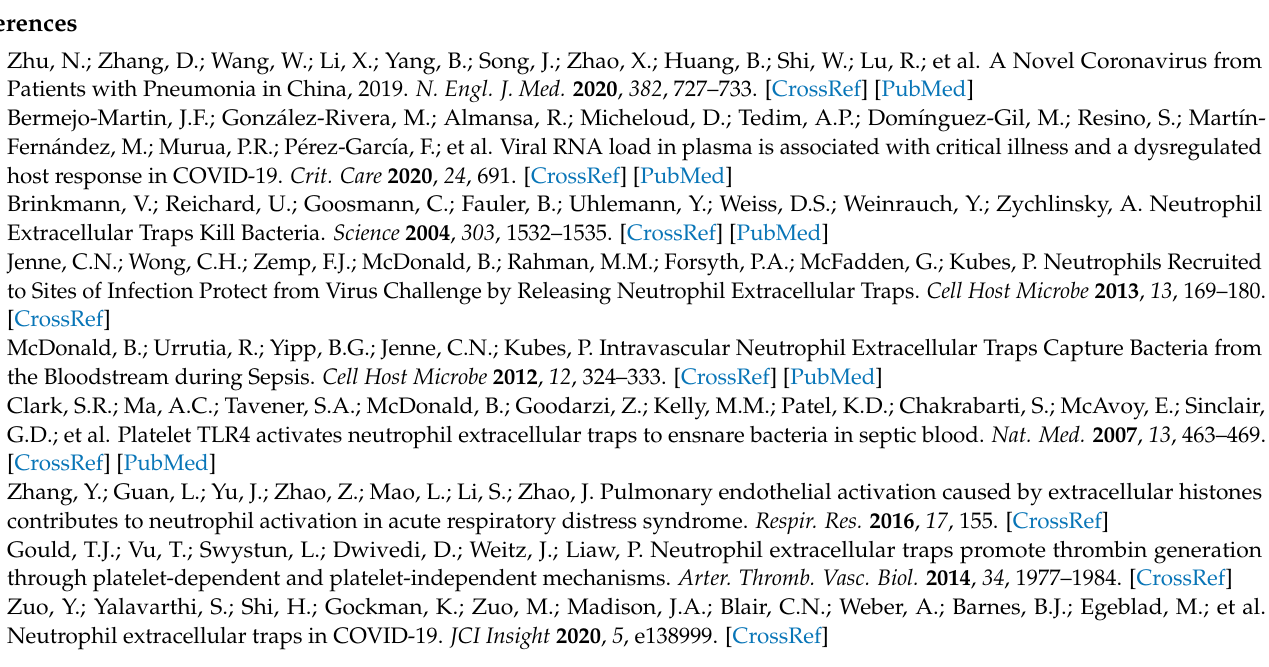
Table S2. Biomarker levels and comorbidities; Table S3. Biomarker levels and clinical outcomes; Table S4. Area Under the Receiver Operating Characteristics Analysis; Table S5. Multistate model; Figure S1. Multistate